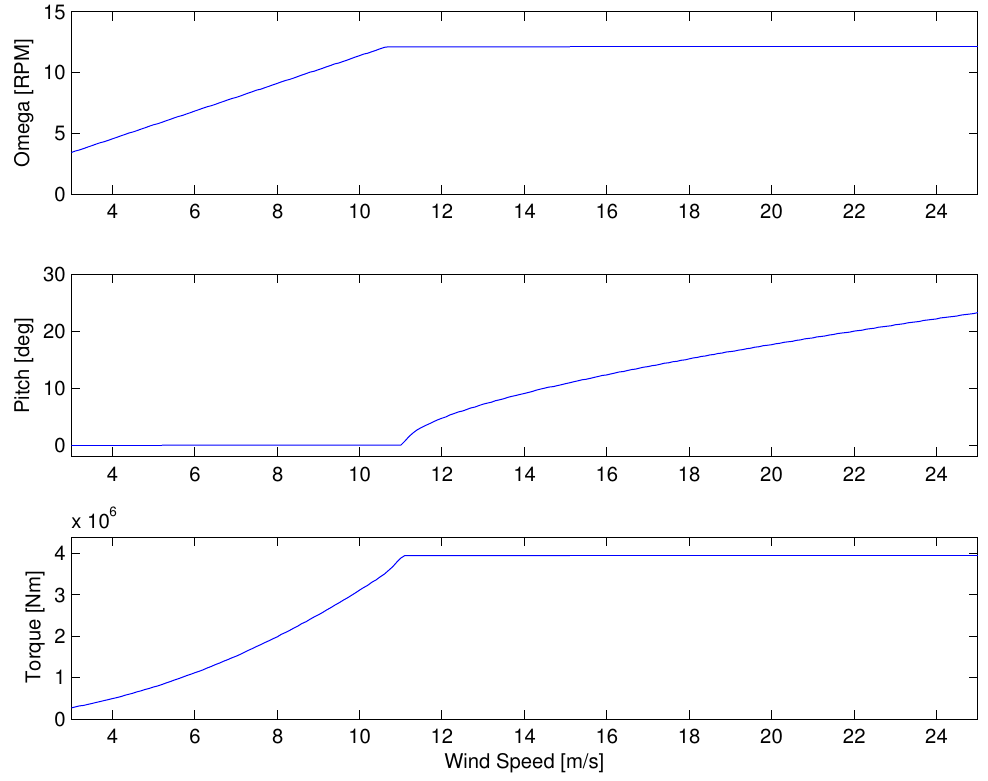
Figure 4. Ideal closed-loop operating strategy to maximize power below rated wind speed and to reduce loads and keep rated power above rated wind